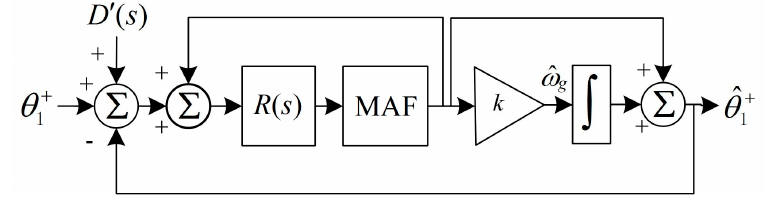
Figure 12. Mathematics model of the proposed PLL.